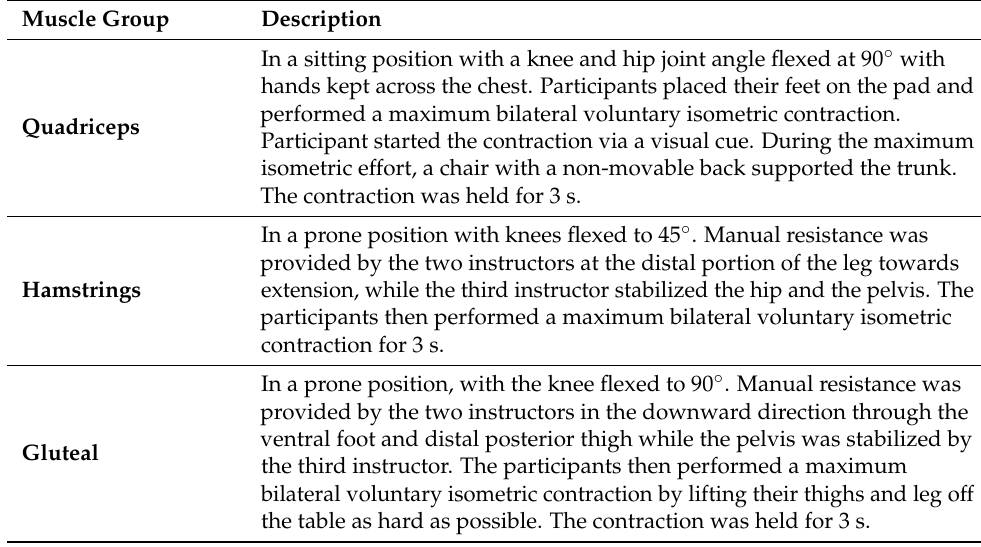
Table 2. Characteristics of maximal voluntary isometric contraction tests for each muscle group. Muscle